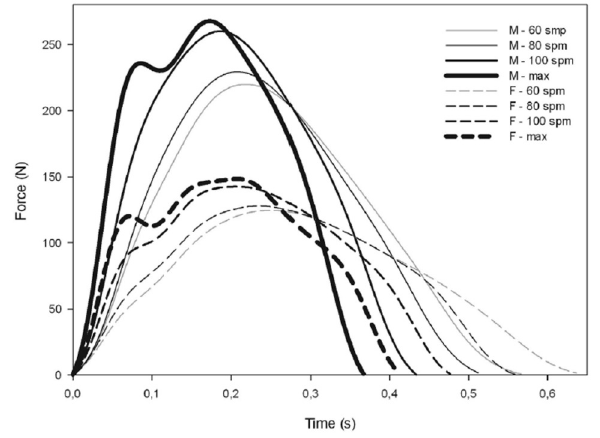
Figure 5. Average force–time curve for each gender and stroke frequency. Each curve represents the normalized mean curve (270, 300, 330 and 360 strokes from both sides at 60, 80, and 100 strokes per minute (spm) and at maximum frequency (max), respectively. M = men, F = women. Graph extracted from Gomes et al. [9]. Table 1. Table of mean ± SD (standard deviation) for the variables of the force–time curve for the canoeing stroke (Figure 5), for each gender and F mean / F max for the whole sample. Extracted from Gomes et al. [9] and adapted. Stroke Freq. a Stroke Freq. Stroke Freq. Stroke